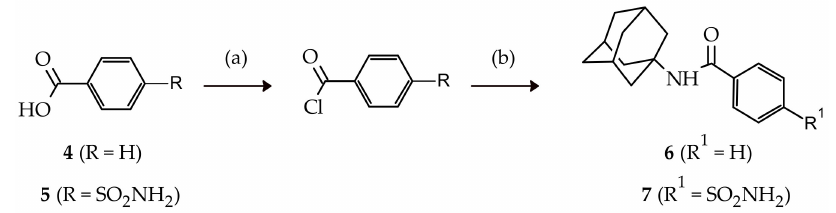
Figure 2. Synthesis of compound 6 and 7 . Reagents and conditions: (a) reflux, DMF, CH 2 Cl 2 , thionyl chloride, 2 h; (b) 25 ◦ C, 1 eq amantadine ( 1 ), CHCl 3 , trietylamine, 2 h or MW, 100 ◦ C, 150 W, 250 psi, 30 min.